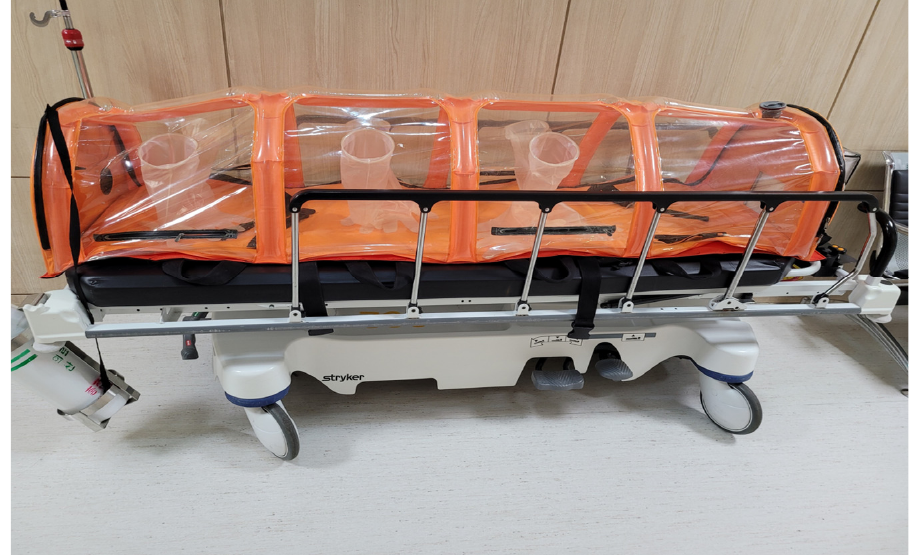
Figure 1. COVID-19 patients are transported using this tent when moving from the ward to the angiography